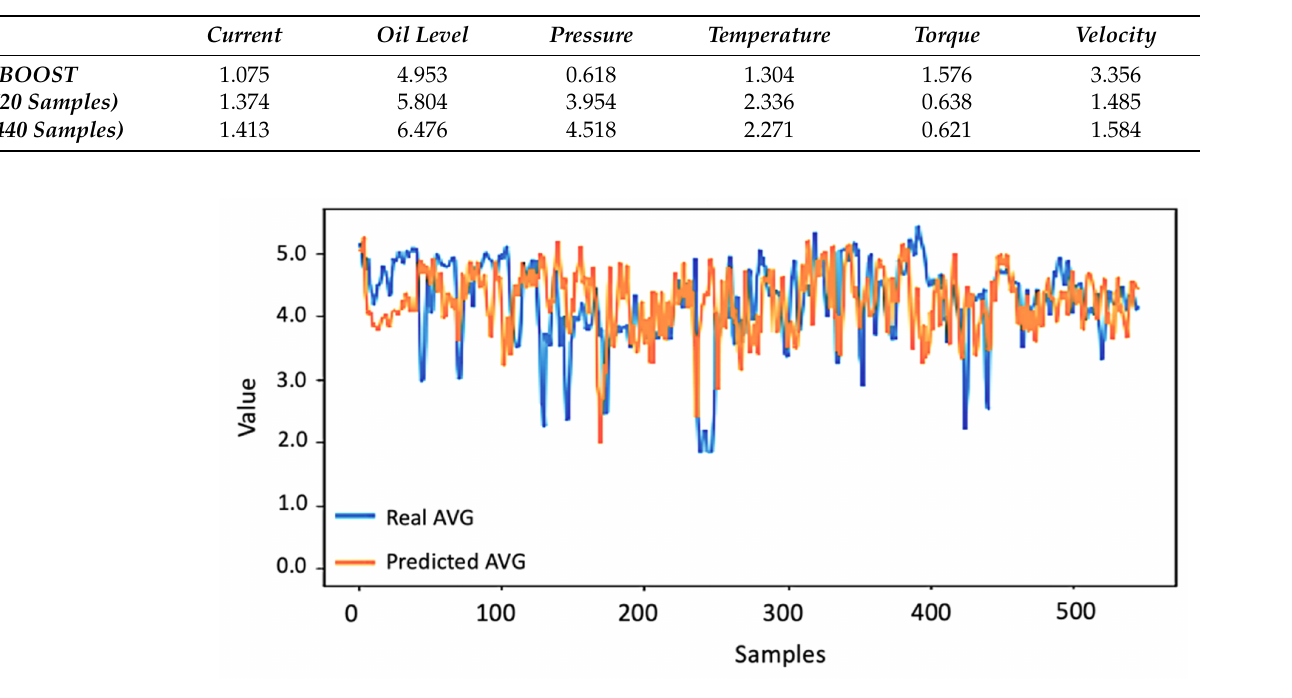
Figure 7. Real and 30-day forecast values (after smoothing) for temperature using